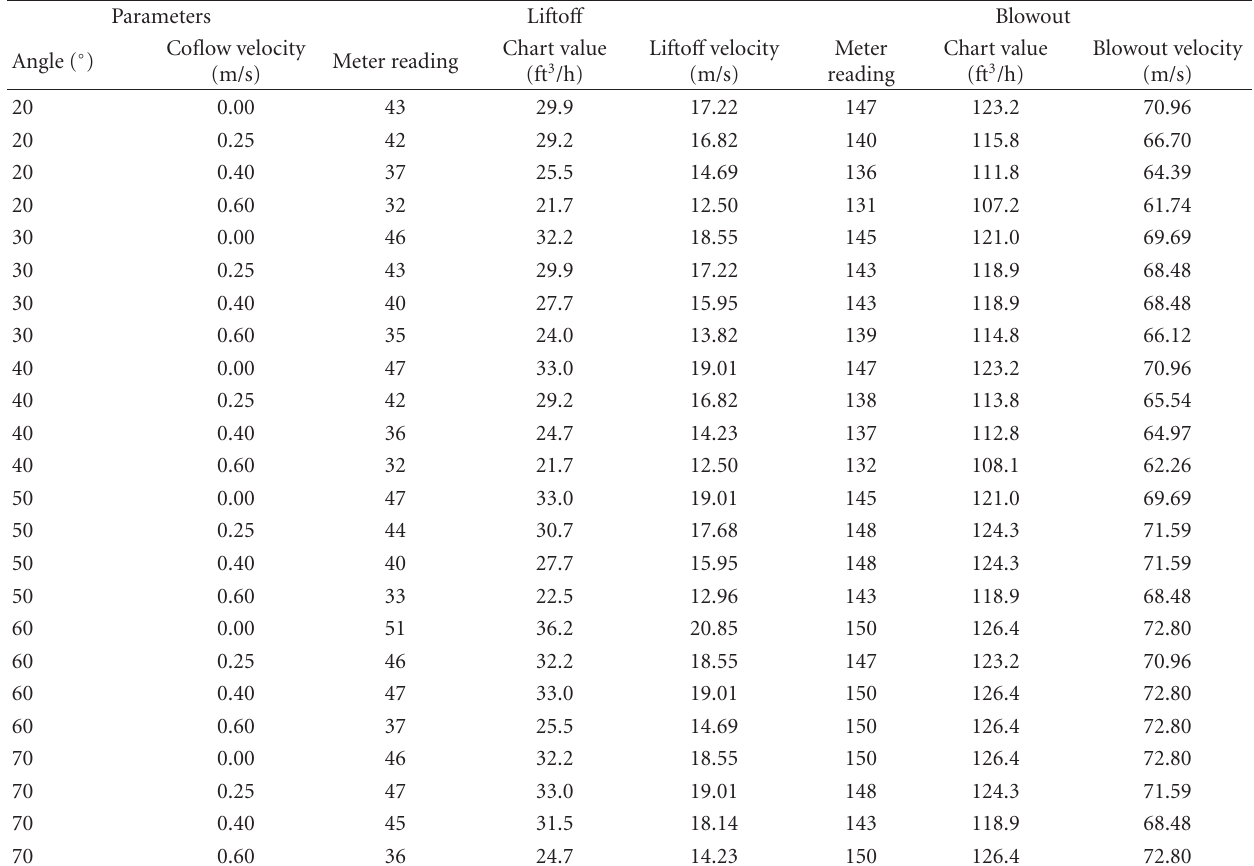
Table 1: Lifto ff and blowout velocities for all flow